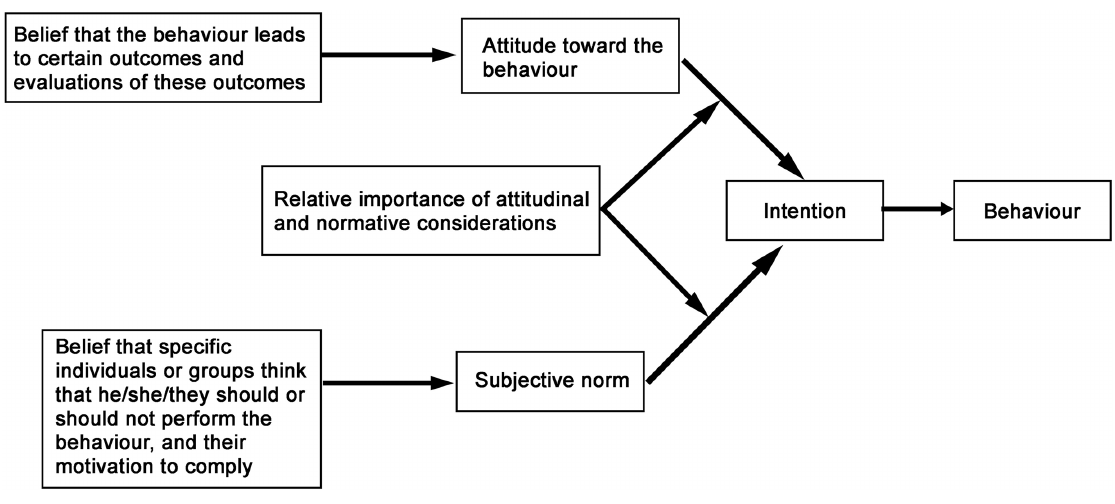
Fig 1. Factors determining a person’s behaviour using the Theory of Reasoned Action (adapted from